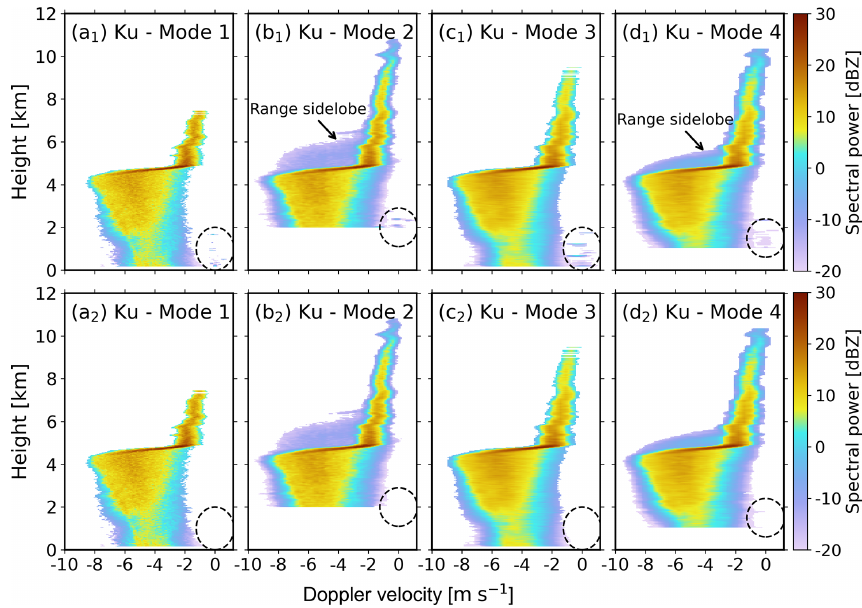
Figure 4. (a1–d1) Noise-removed Ku-band Doppler power spectra on 6 June 2020 at 22:52:08LST recorded at (a1) mode 1, (b1) mode 2, (c1) mode 3, and (d1) mode 4. (a2–d2) Decluttered observations. The dashed circles mark the clutter signals. Note that the heights below 2 and 1km are blind zones for modes 2 and 4,